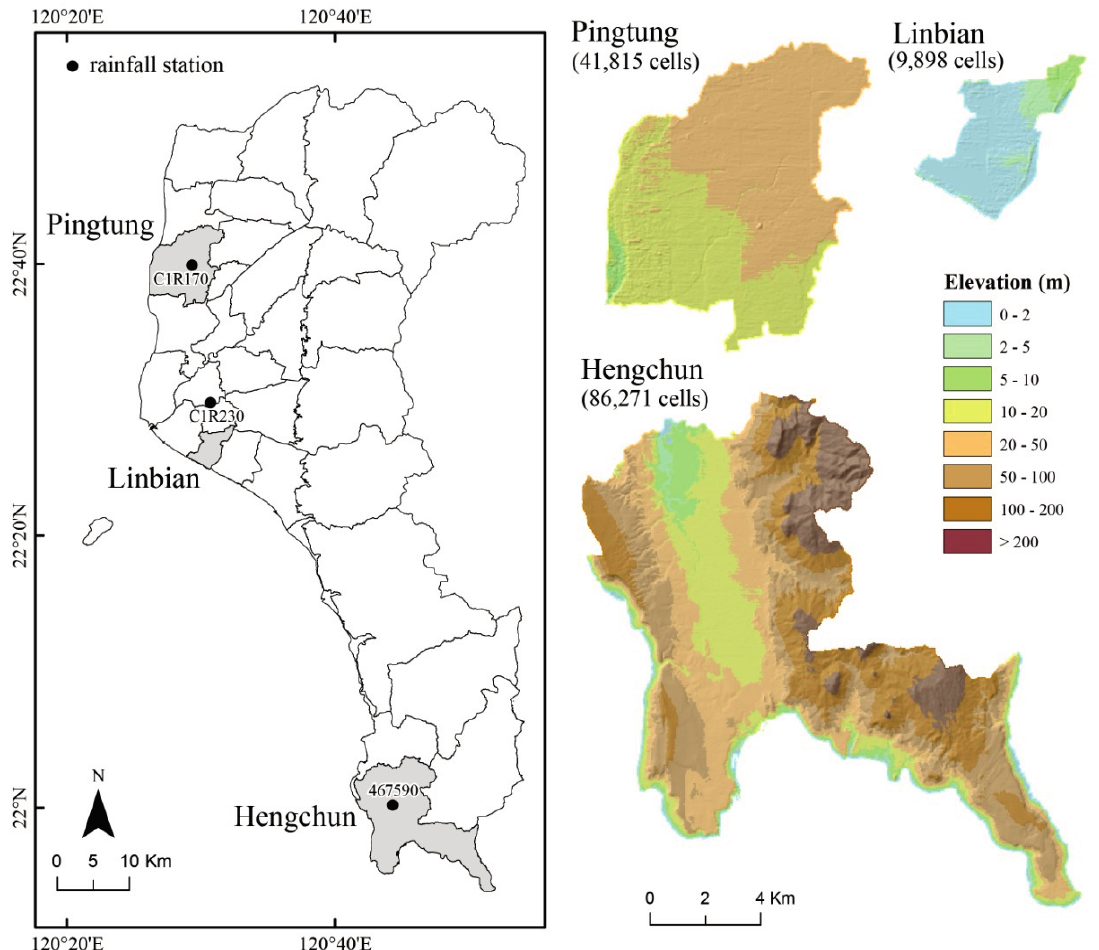
Figure 5. Map of Pingtung County and three selected towns, Pingtung, Linbian, and Hengchun. The 40 m × 40 m DEMs were used to implement the SPM. There are 41,815 cells in Pingtung, 9898 cells in Linbian, and 86,271 cells in Hengchuen. 1% of the cells was assumed as route starting